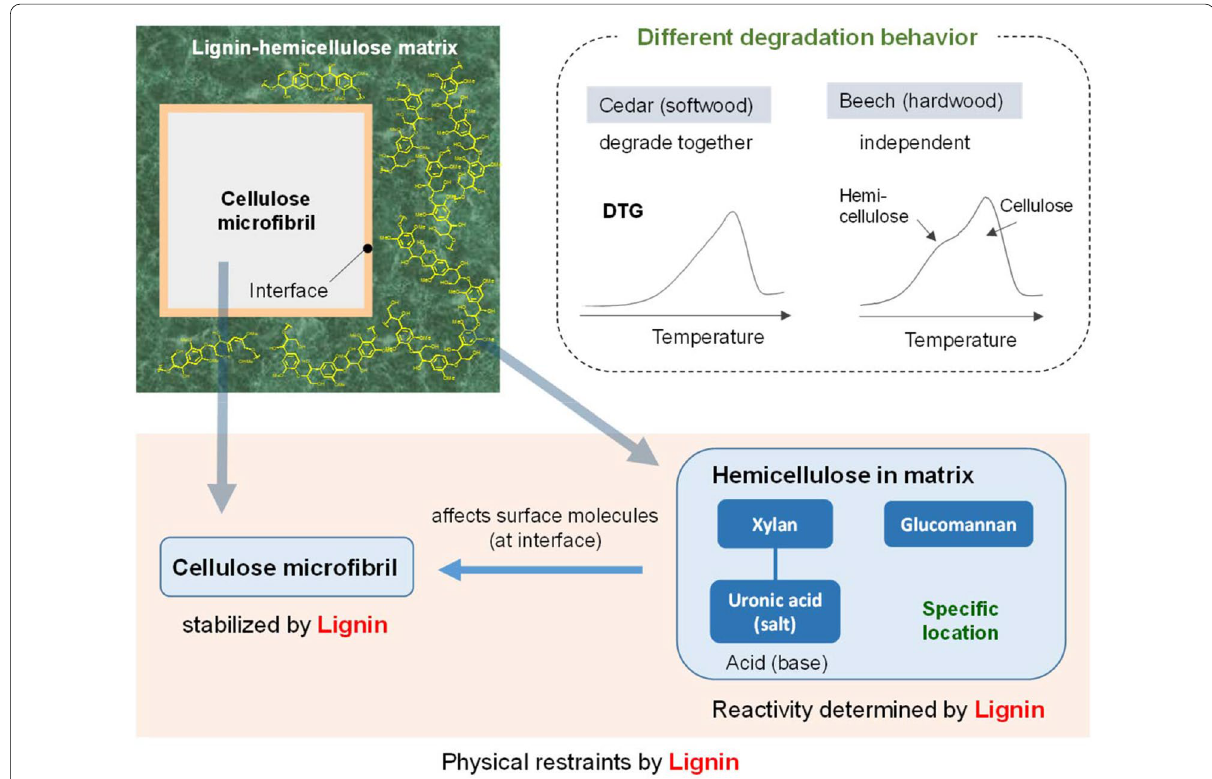
Fig. 7 A proposed role of lignification in determining thermal degradation reactivities of cellulose and hemicellulose in cedar (softwood) and beech (hardwood)